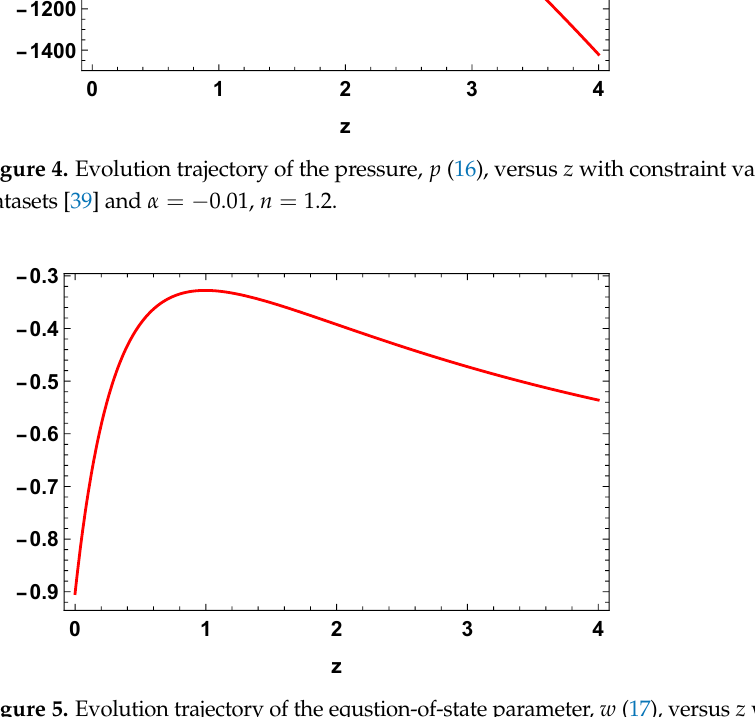
Figure 5. Evolution trajectory of the equstion-of-state parameter, w (17), versus z with constraint values from the Hubble datasets [39] and α = − 0.01, n =